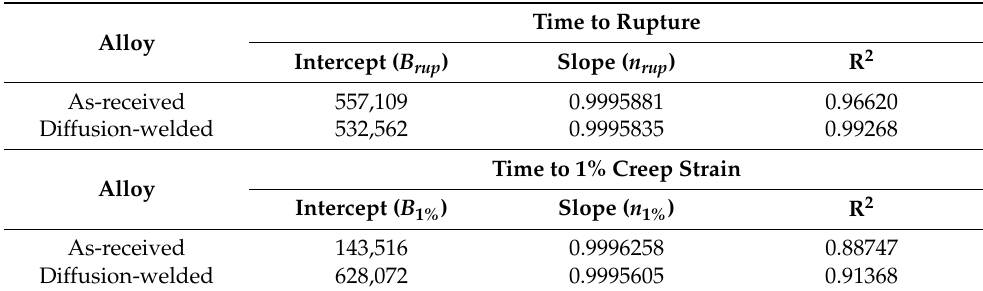
Table 4. The intercept and the slope in the Larson–Miller relation (Equation (3)). C in Equation (2) is fixed to 16.73 for both the time to rupture and the time to 1% creep